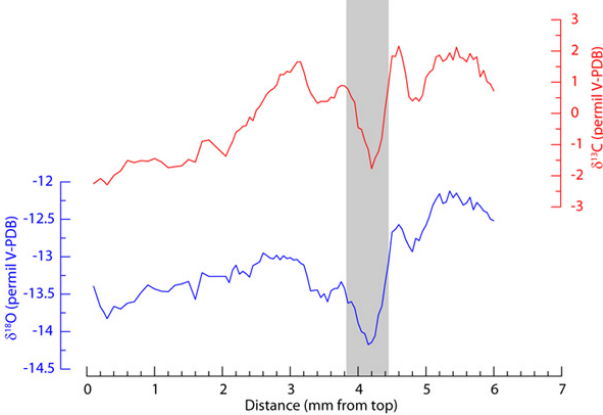
Fig. 9. Profile of δ 13 C and δ 18 O variations with depth in stalactite 2-N obtained by micro-drilling and conventional acid dissolution analysis. The grey area corresponds to a